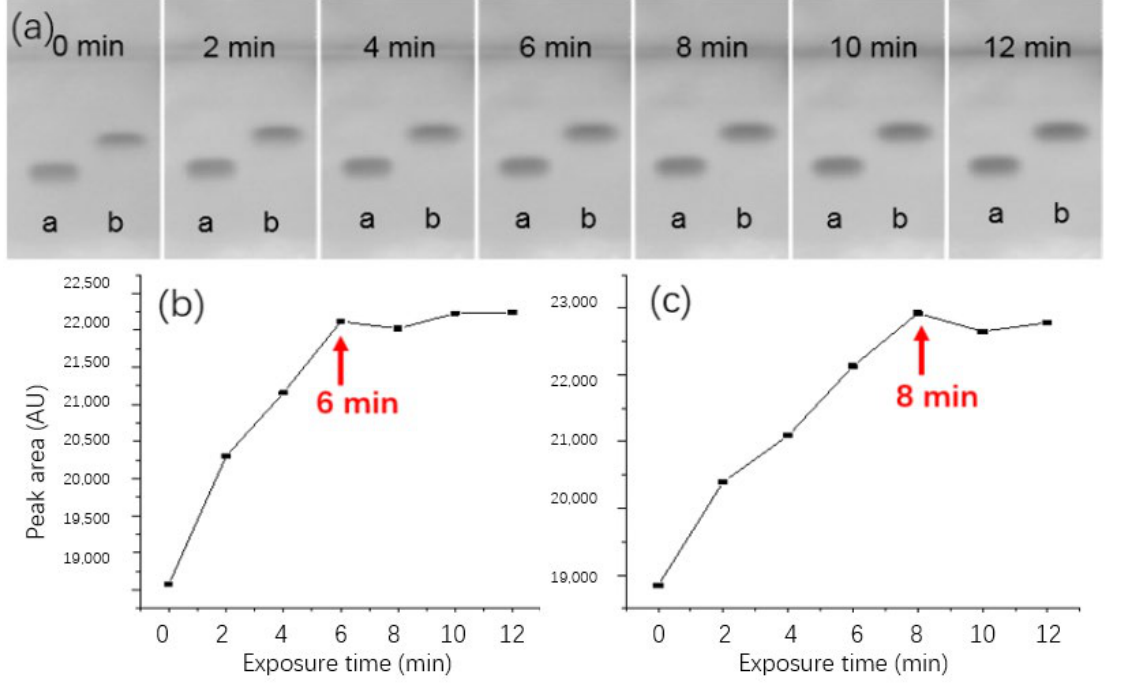
Figure 2. ( a ) The change of bioluminescent inhibition pattern within the initial 12 min after dipping. Track assignment: a—BZF, b—CPF; corresponding peak area variation profile for ( b ) BZF and ( c ) CPF.